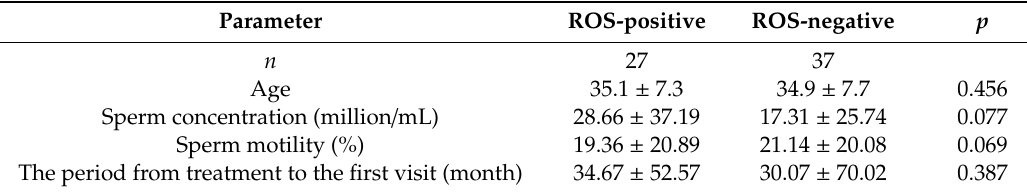
Table 3. Comparison between ROS-positive and ROS-negative samples in the postchemotherapy